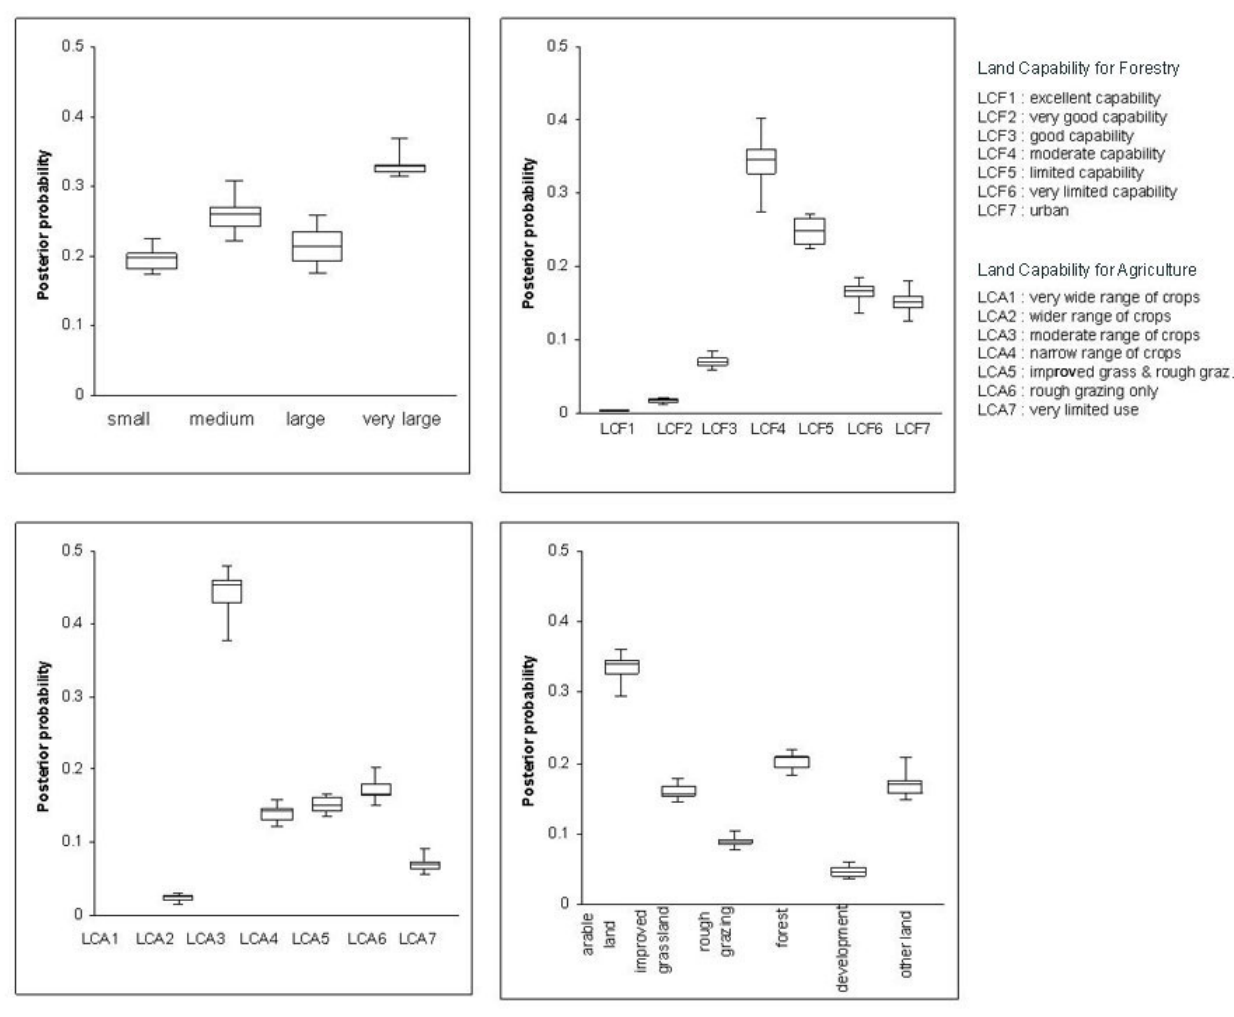
Fig. 4. Boxplots of the mean posterior probability distribution for area of